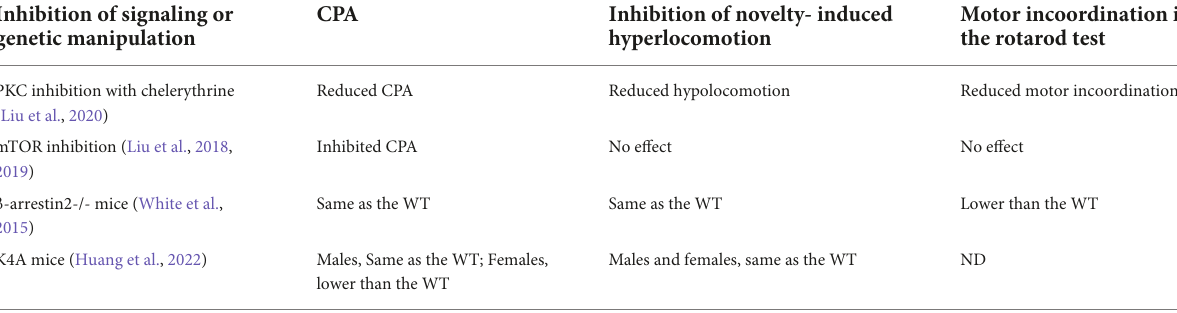
Motor incoordination in the rotarod test